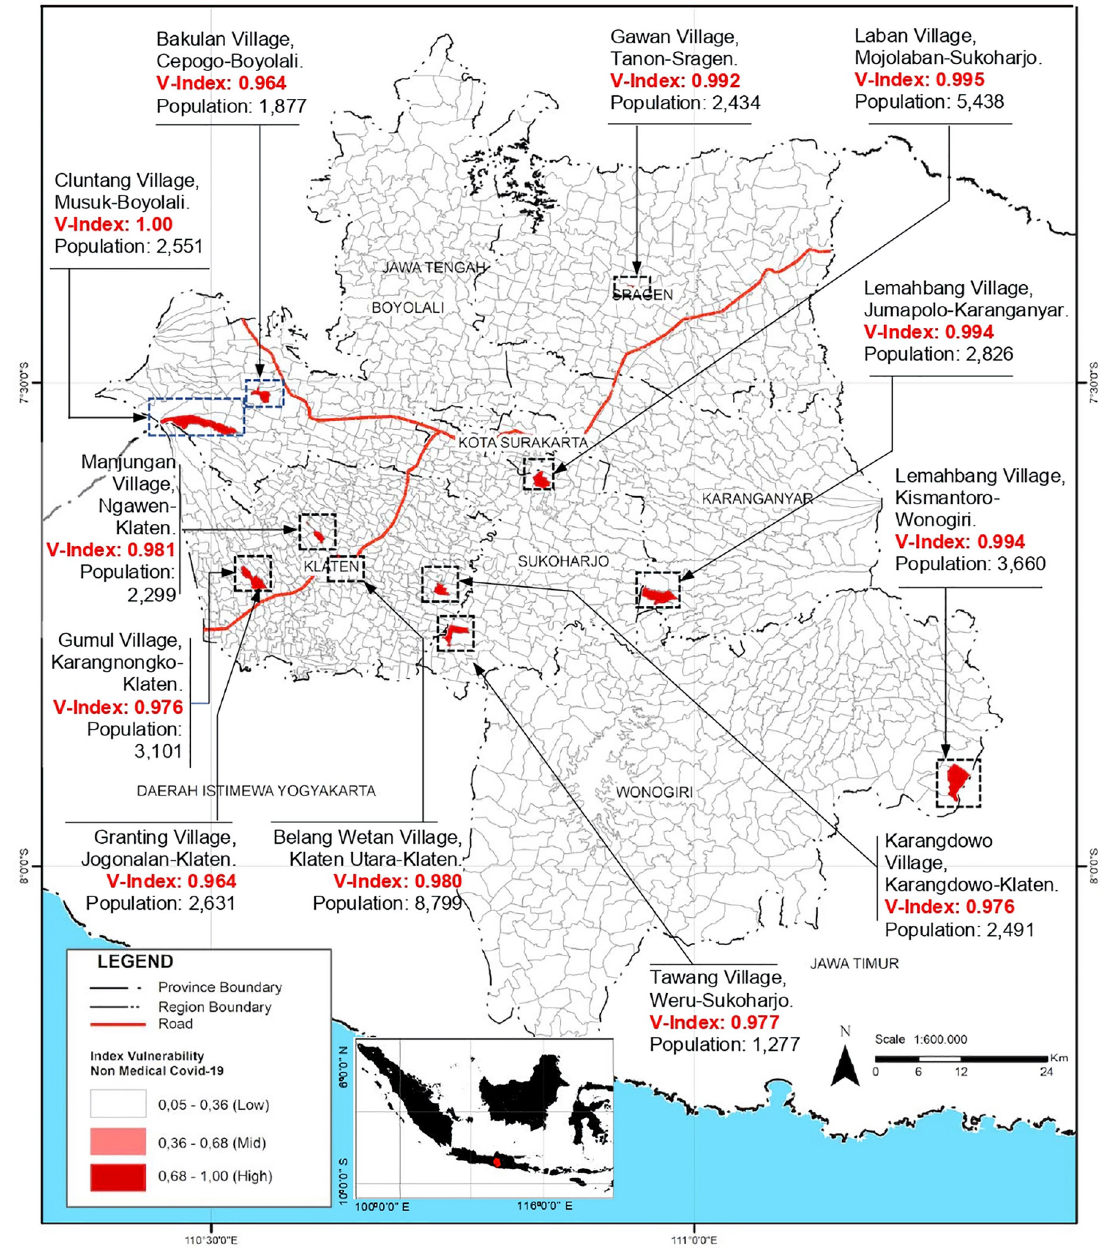
Fig. 9. The high vulnerability villages in Greater